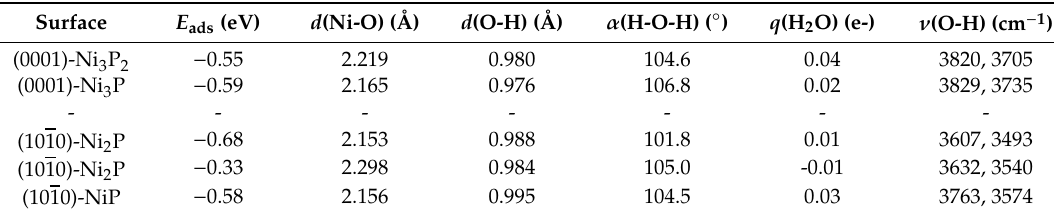
Figure 3. The optimized structures of the most favourable adsorption configurations of molecular H 2 O on the ( a ) Ni 3 P 2 - and ( b ) Ni 3 P-terminations of (0001) surface. The corresponding isosurfaces contours of the charge density difference for adsorbed H 2 O molecule are shown in ( c ) and ( d ). The cyan and yellow contours indicate electron density accumulation and depletion by ±0.003 e/Å 3 , respectively. Table 1. Molecular adsorption energies (E ads ), bond lengths (d), bond angles ( α ), Bader charge of adsorbed water ( q (H 2 O)), and vibrational frequencies ( υ ) for water adsorption on Ni 2 P (0001) and (1010) surfaces. The gas phase O–H stretching modes are predicted at 3988 and 3866 cm − 1